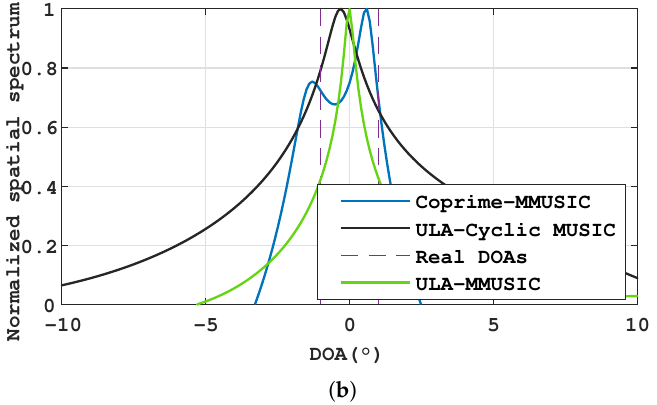
Figure 4. Resolution comparison results. ( a ) The proposed method; ( b ) ULA-based Cyclic-MUSIC algorithm, ULA-based MMUSIC algorithm and coprime-based MMUSIC algorithm.